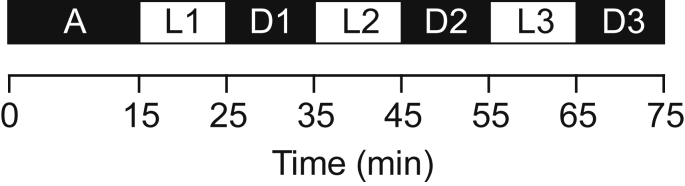
Timeline of the locomotor activity assay protocol consisting of an acclimatization step (A), and six alternating light (L1-L3) and dark (D1-D3) periods.